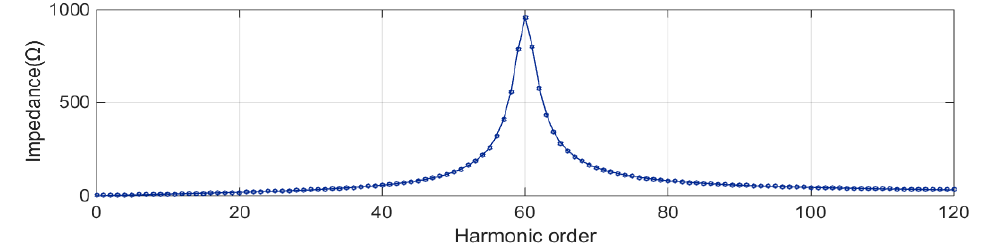
Figure 25. Impedance characteristic diagram of resonant circuit.